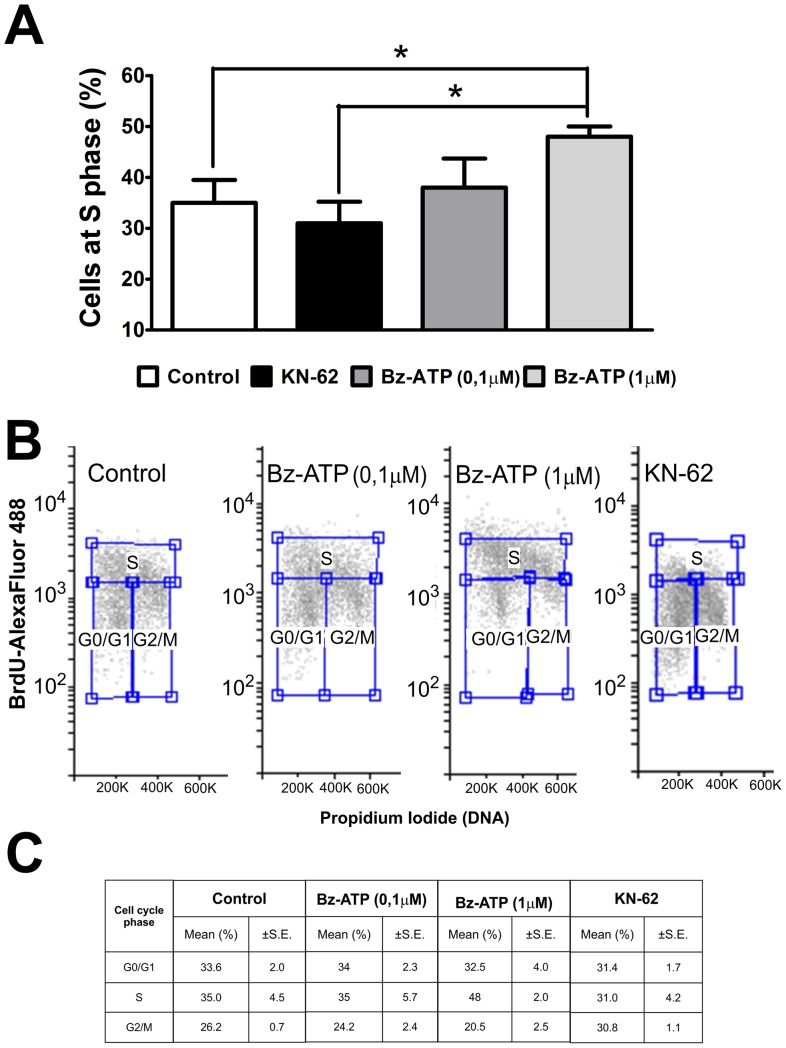
Proliferation of ESC in conditions of P2X7R modulation.Cell cycle analysis based on flow cytometric analysis of BrdU incorporation and propidium iodide DNA-staining were performed as described in Materials and Methods. (A) Cell distributions at different S-phases of ESC treated with P2X7R agonist or inhibitor, 0.1 µM and 1 µM Bz-ATP and 10 µM KN-62 for 96 h, respectively. Shown data are representative for mean values ±S.E. of five independent experiments. Data were statistical analyzed by the One-Way ANOVA test followed by the Bonferroni post hoc test with (*p<0,05 compared to control data). (B) Representative BrdU/PI cell cycle analysis of ESC treated with Bz-ATP or KN-62 compared to untreated control cultures. (C). Cell cycle distributions of ESC treated for 96 h with the P2X7R agonist (0.1 µM or 1 µM Bz-ATP) or the P2X7R inhibitor KN-62 (10 µM), respectively. Shown data are representative for mean values ±S.E. of five independent experiments.